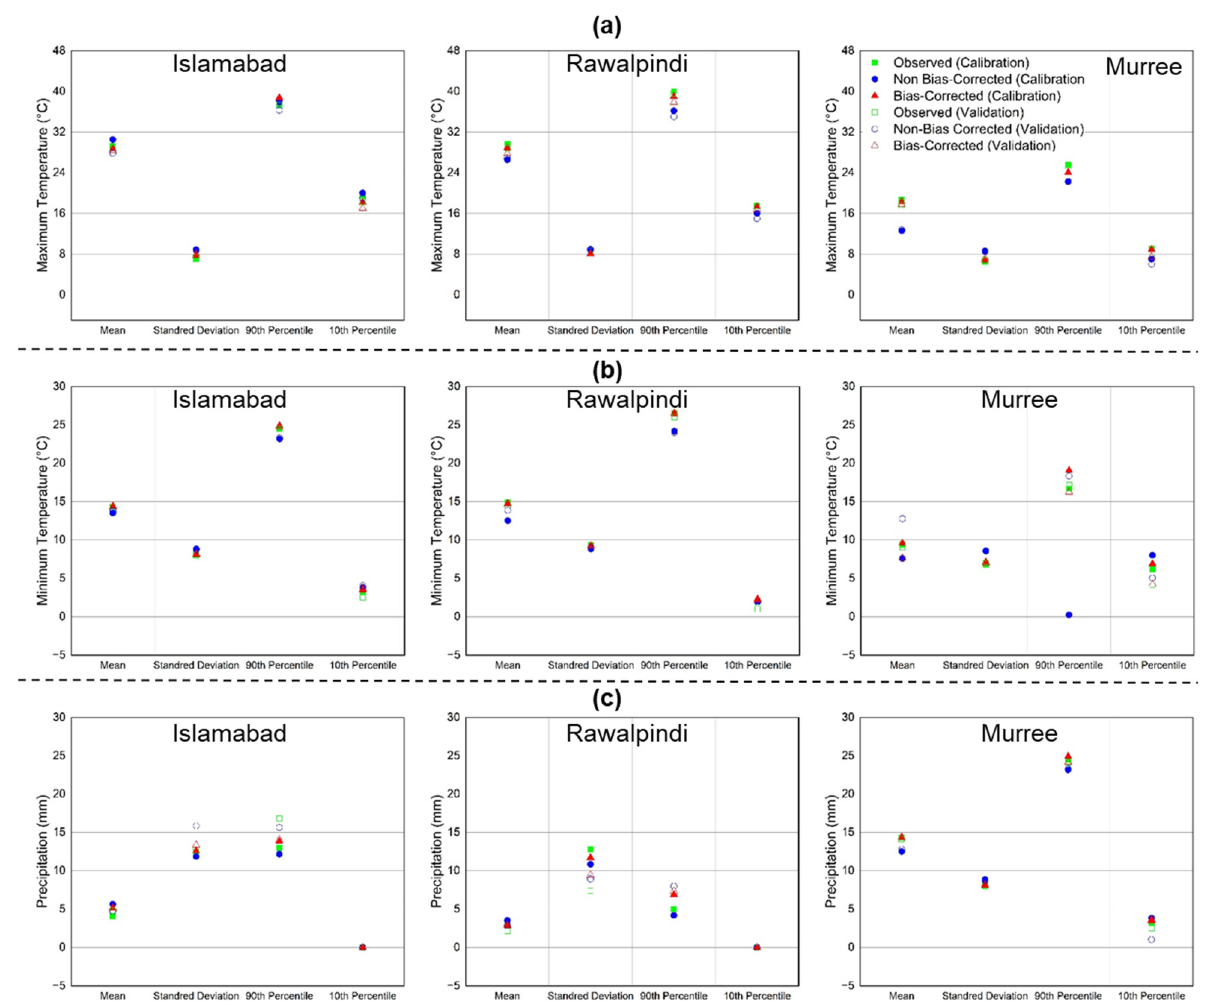
Figure 4. Statistical analysis (mean, standard deviation, 90th percentile, and 10th percentile) of ( a ) maximum temperature ( T max ), ( b ) minimum temperature ( T min ), and ( c ) precipitations for Rawalpindi, Islamabad, and Murree station. Red, green, and blue colors represent bias corrected, observed, and non-bias corrected data points, respectively. Filled, and hollow points represent statistical sign through standardization and authentication periods,